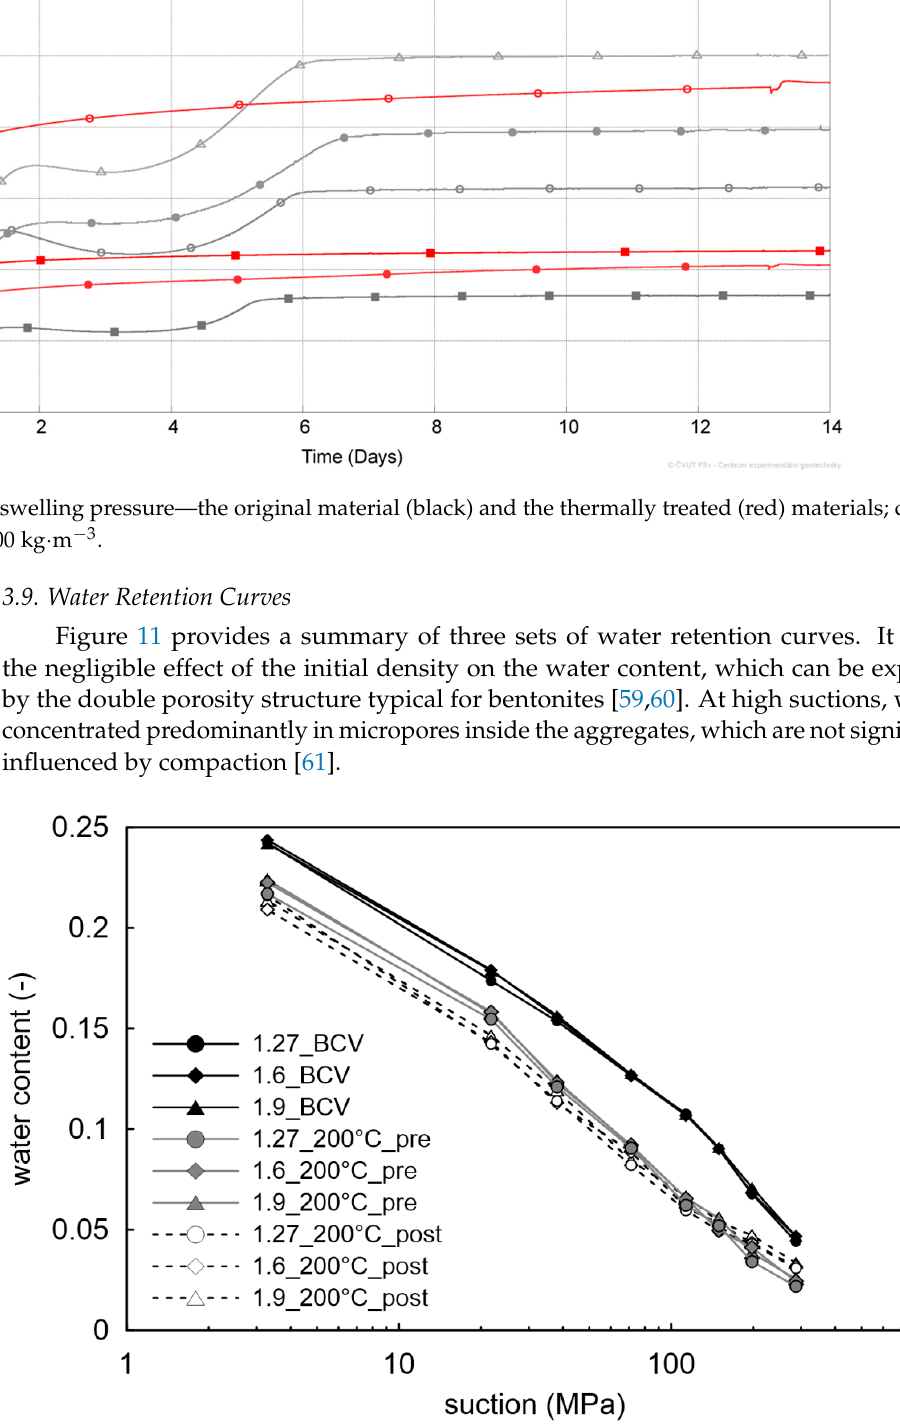
Figure 11. Water retention curves determined for three sets of samples of BCV 2017. The samples compacted before thermal treatment are marked “pre”, while the samples compacted after thermal loading are marked “post”.